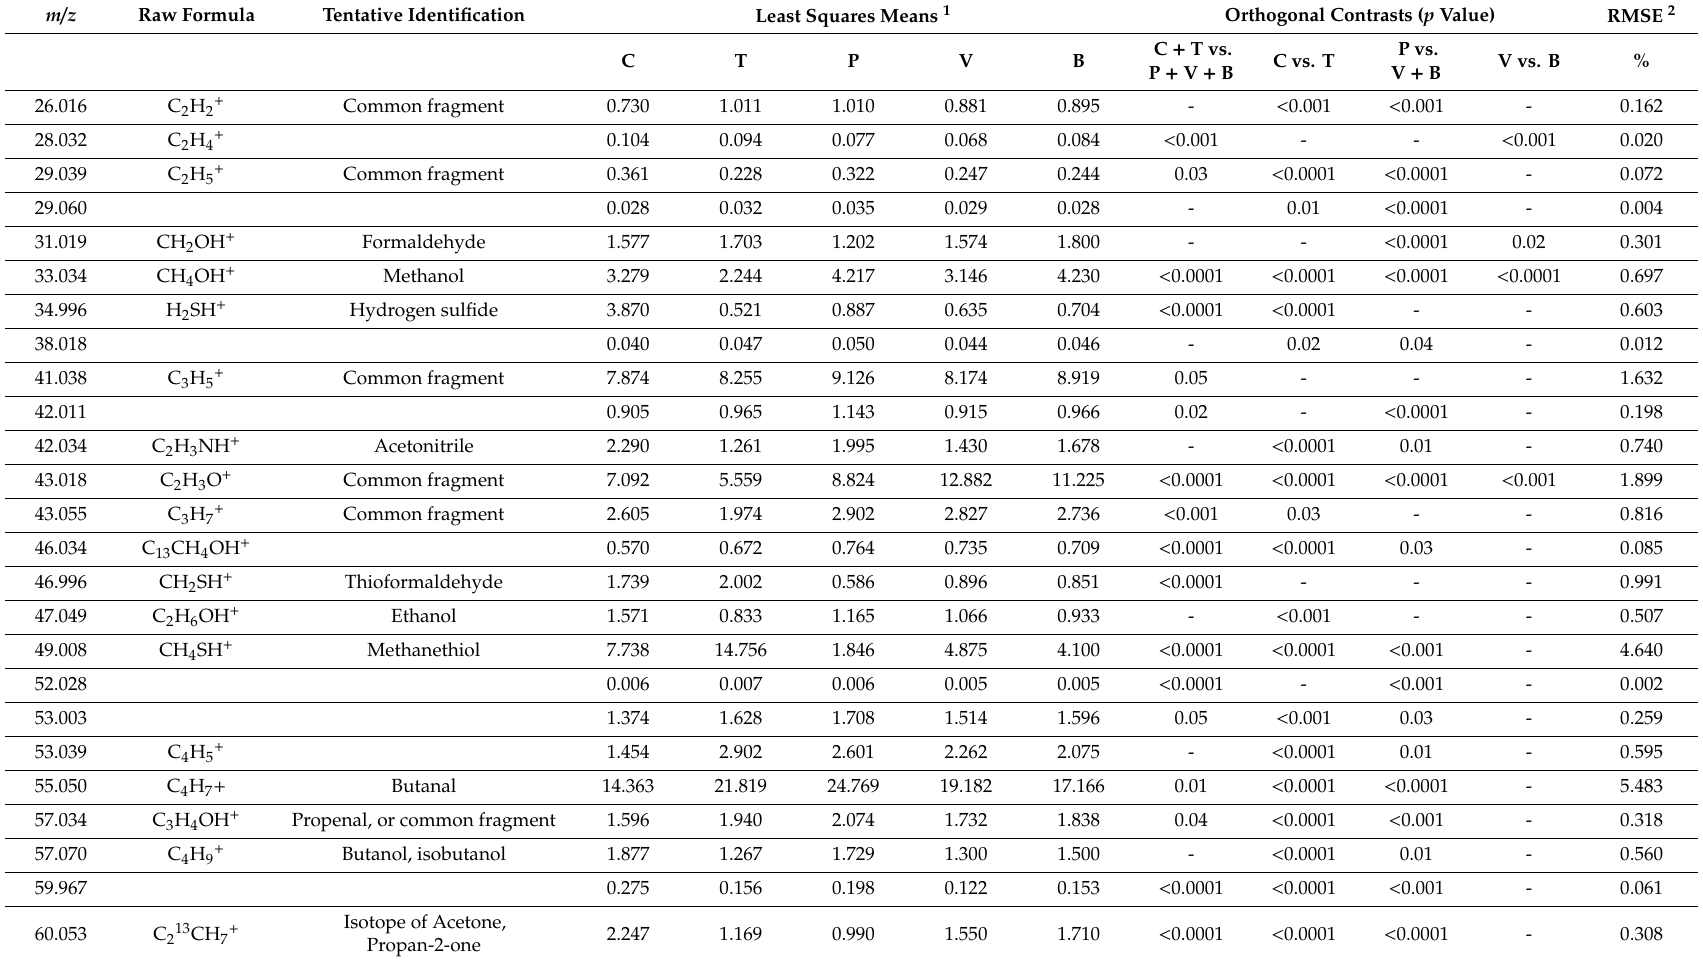
Table 2. E ff ects of meat species and category on the least square means and the contrast significance of the relative percentage incidence of the area of each volatile mass peak on the sum of all 129 mass peaks of cooked meat